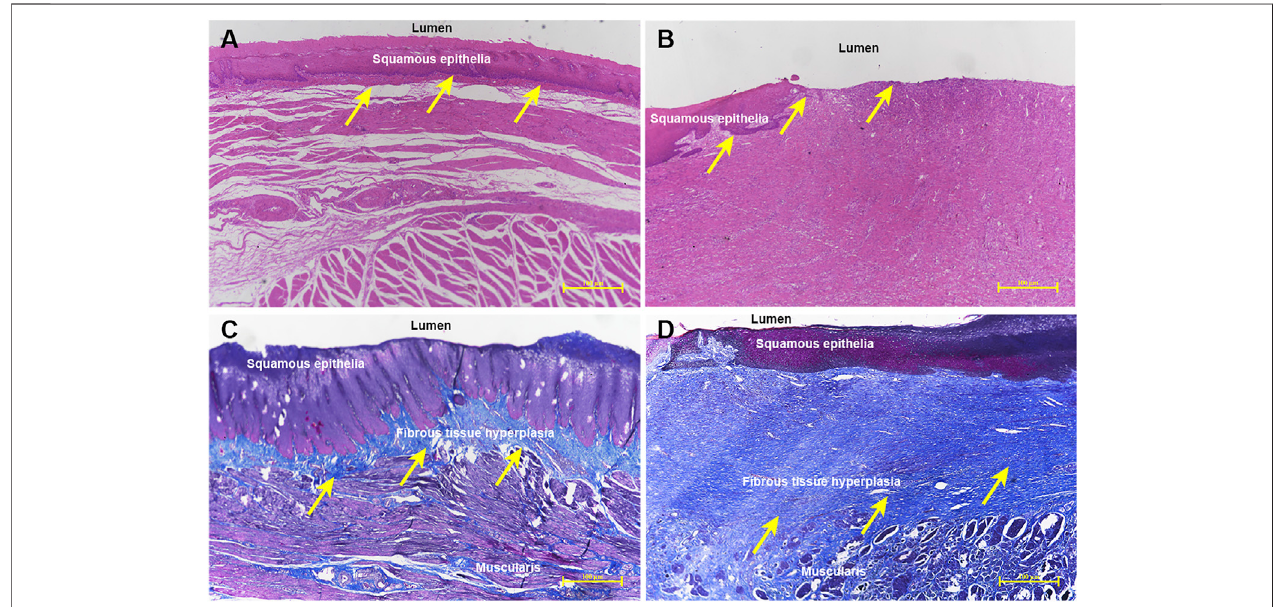
FIGURE 5 | Histological comparison of the ADM-FCSEMS group (A) and FCSEMS group (B) . Hematoxylin-eosin staining reveals (A) an ESD wound covered by abundant continuous and integrated neoepithelium in group A (yellow arrows, ×40) and (B) irregular and unattached re-epithelium in the process of wound healing in group B (yellow arrows, ×40). Masson ’ s trichrome staining demonstrates (C) less submucosal fi brosis in group A (yellow arrows, 40×) and (D) obvious submucosal fi brosis formation and structural disorder in group B (yellow arrows, ×40).